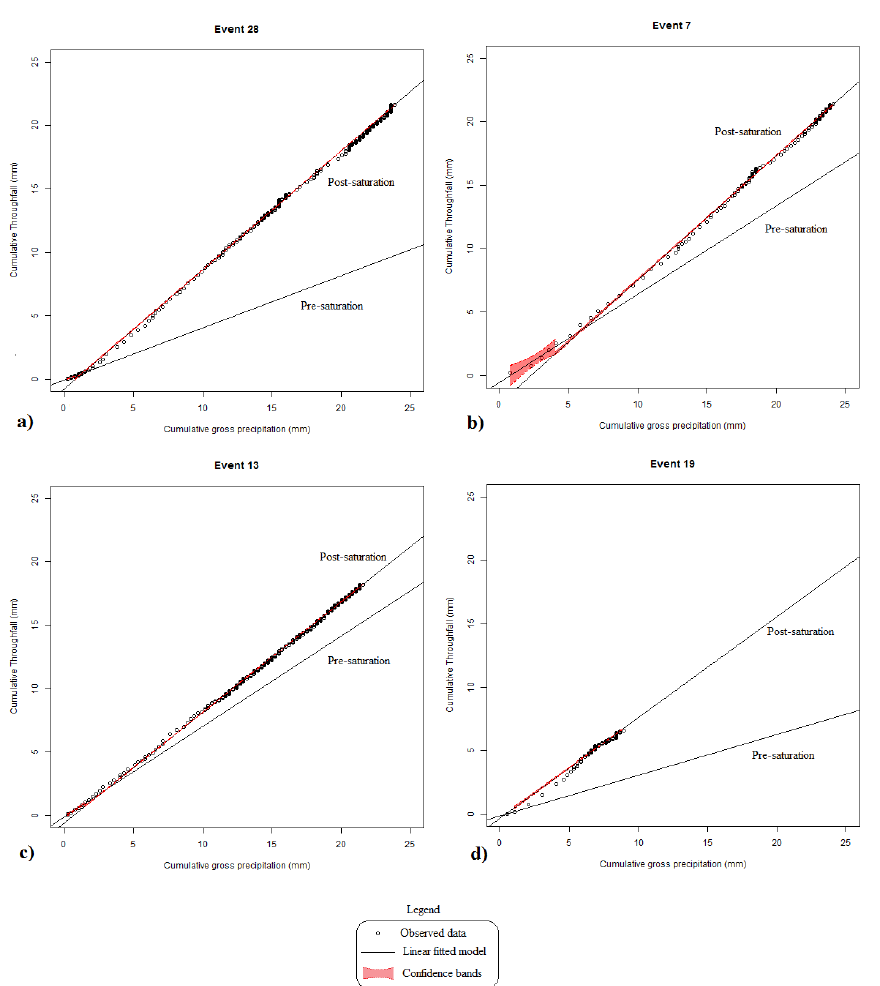
Figure 8. Examples of field data fit to IS method: ( a ) Event 28; ( b ) Event 7; ( c ) Event 13; and ( d ) Event 19.